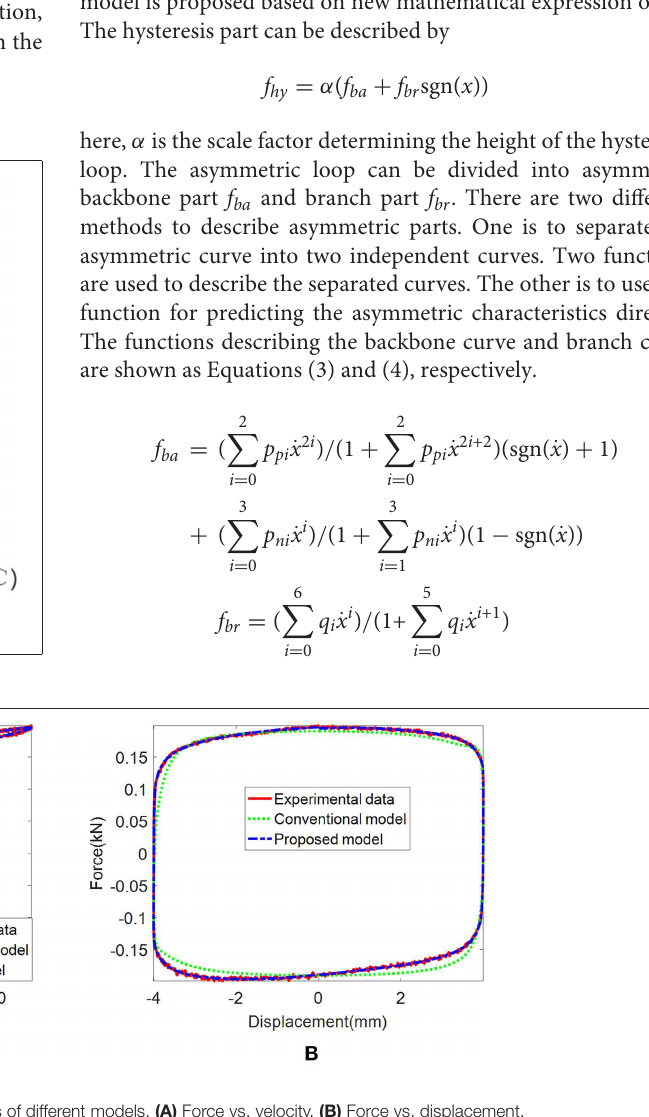
Frontiers in Materials |